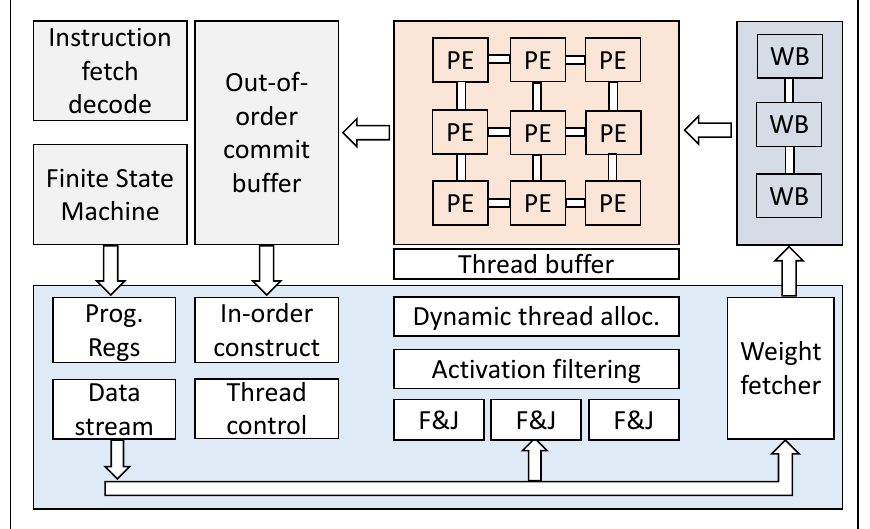
Figure 2. The FPGA NN engine accelerator architecture for neural